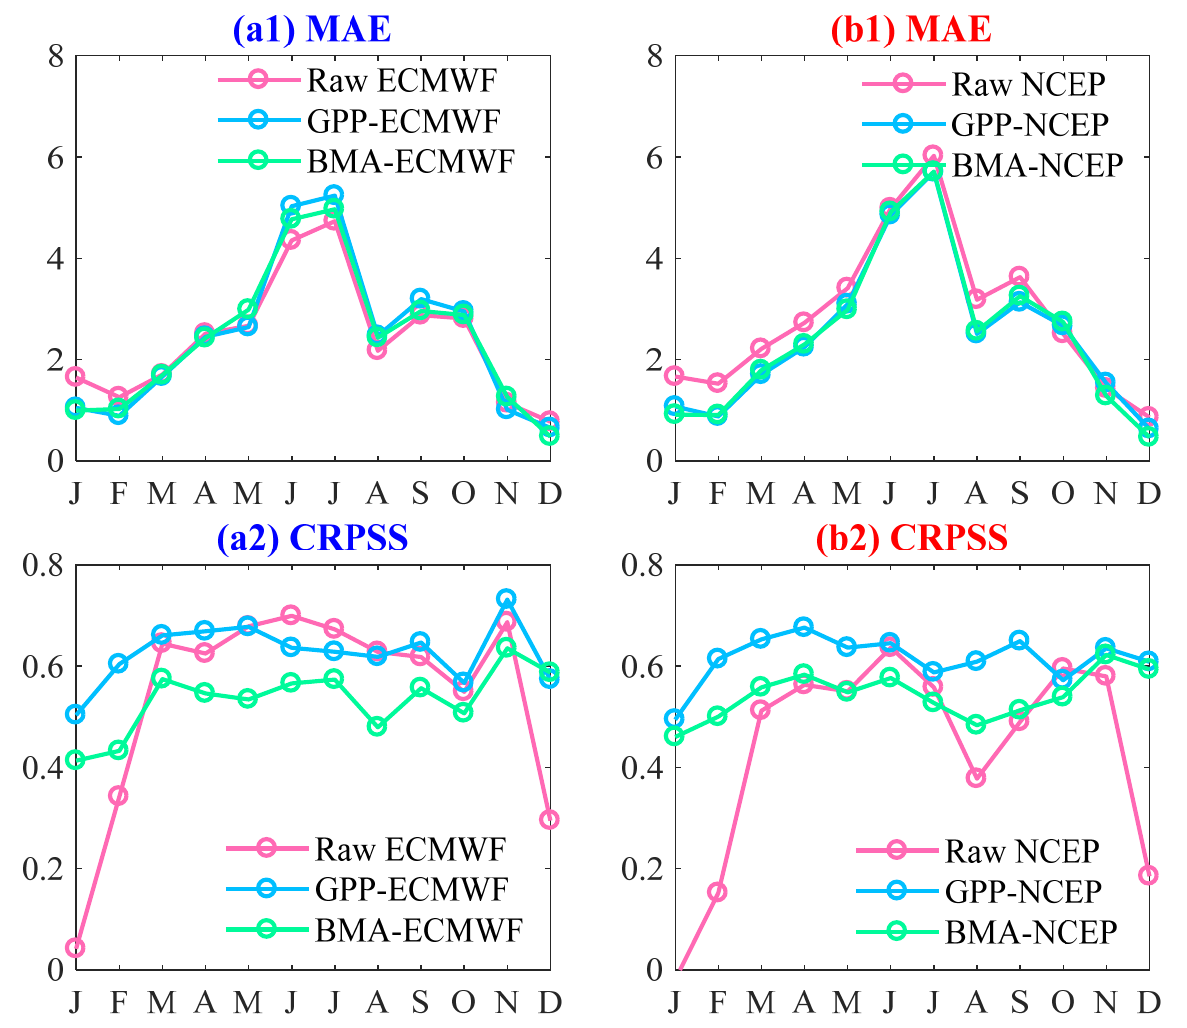
Figure 5. Monthly variation of evaluation indexes for ensemble precipitation forecasts by raw and postprocessed ECMWF ( a1 , a2 ) and NCEP ( b1 , b2 ).